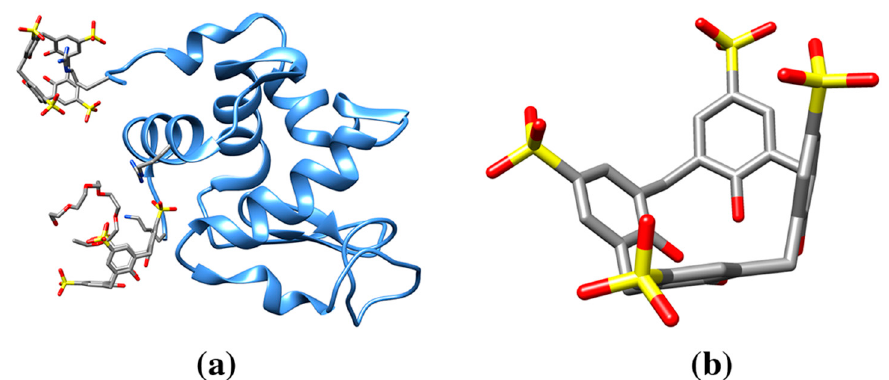
Figure 4. ( a ) Ribbon drawing of egg-white lysozyme in complex with sulfonatocalix[4]arene (sclx 4 ) (pdb entry 4prq). The structure shows one calixarene molecule “cupping” an arginine side chain and therefore, camouflages the surface amino acid positive charge. The second calixarene molecule hosts a PEG molecule fragment (stick representation) from crystallization medium. ( b ) Sulfonatocalix[4]arene molecule (cif code T3Y, S yellow). The sclx 4 molecule is also able to selectively recognize post translational modifications of lysine residues, as observed in the crystal structure of sclx 4 bound to dimethyllysine residues of lysozyme (pdb entry 4n0j, Table 1) [94].